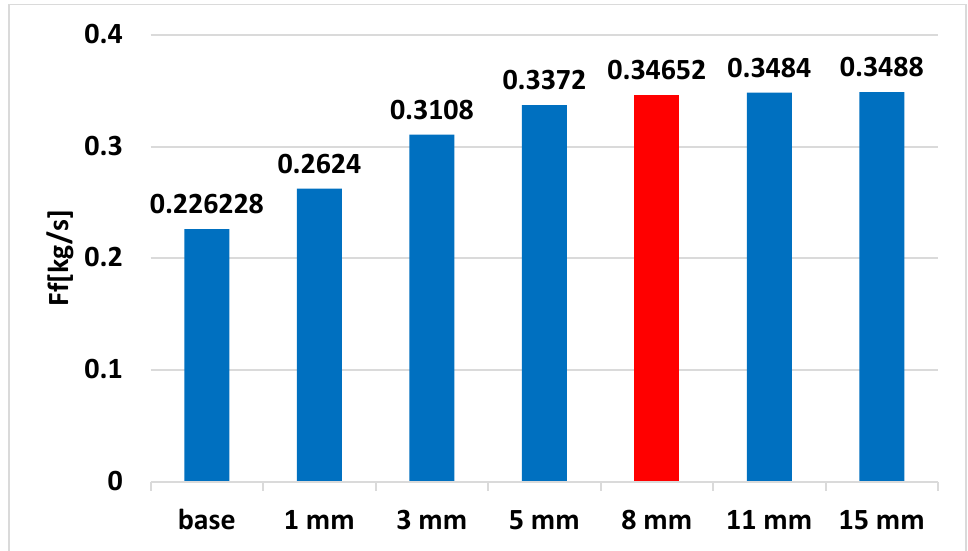
Figure 14. The variation of the gas flow rate read in section 3 obtained through numerical simulations for the variation of section 5.